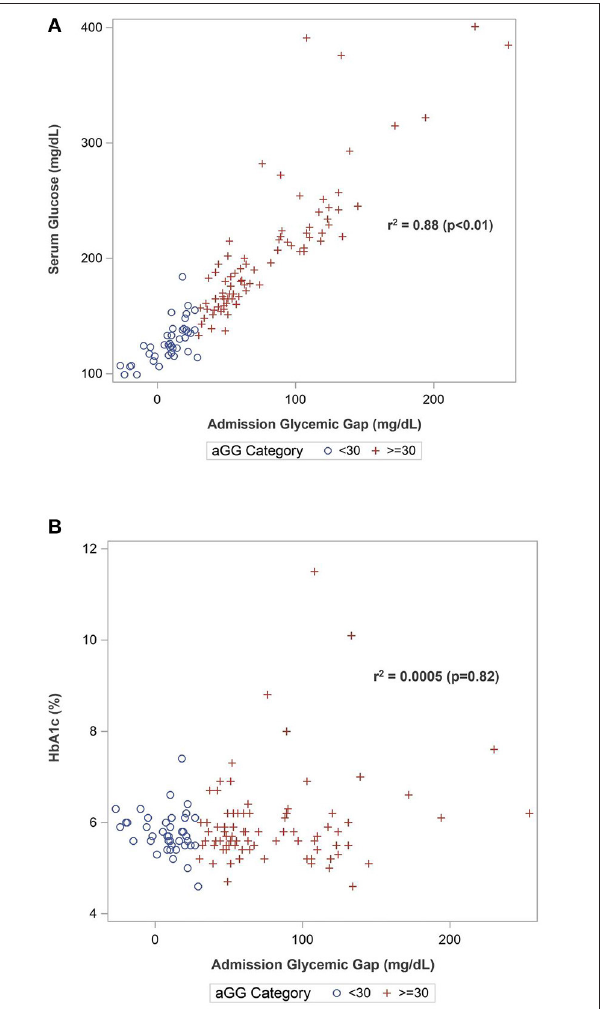
FIGURE 1 | Scatterplots of Spearman’s correlation between admission glycemic gap with (A) admission serum glucose and (B)